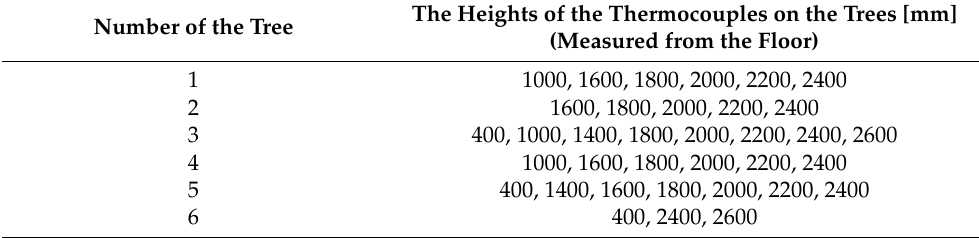
Table 1. Summary of thermocouple trees.